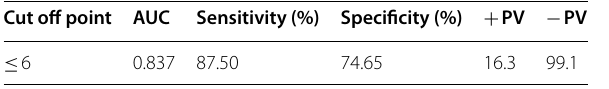
AUC Area under curve, value